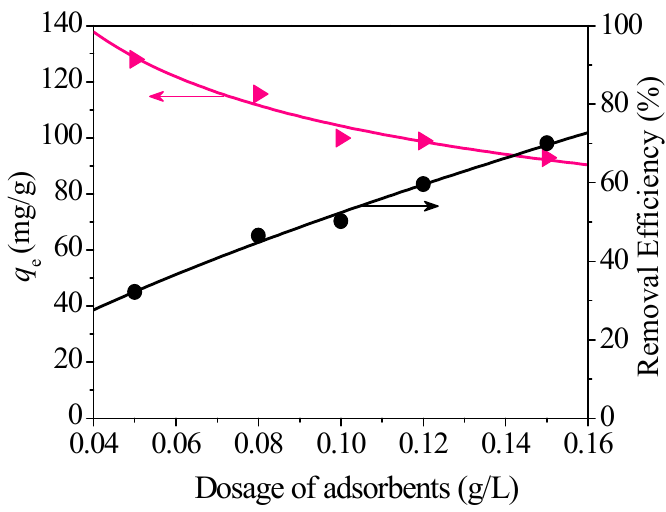
Figure 10. Effect of adsorbent dosage on the removal of Hg(II).